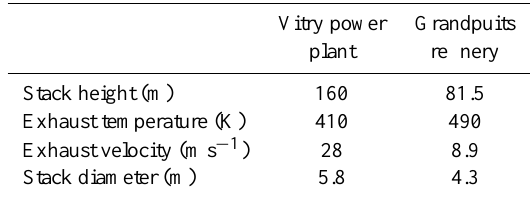
Table 4. Characteristics of the industrial stacks treated in the PinG model.